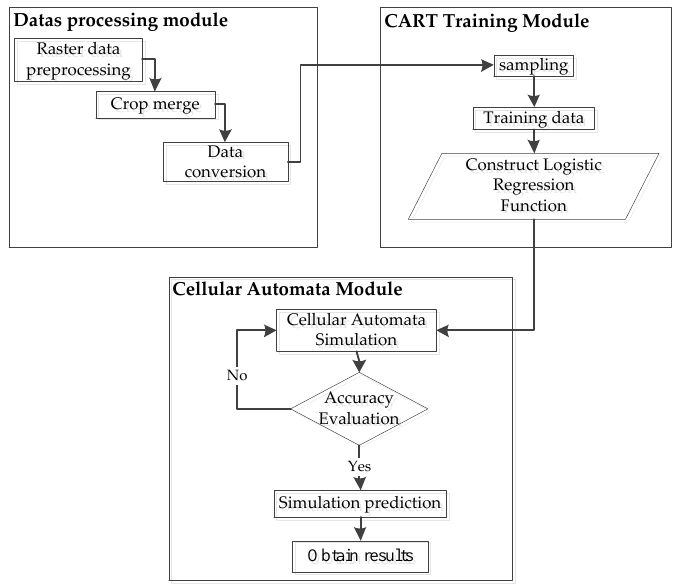
Figure 2. The basic architecture of the cellular automata (CA) model.